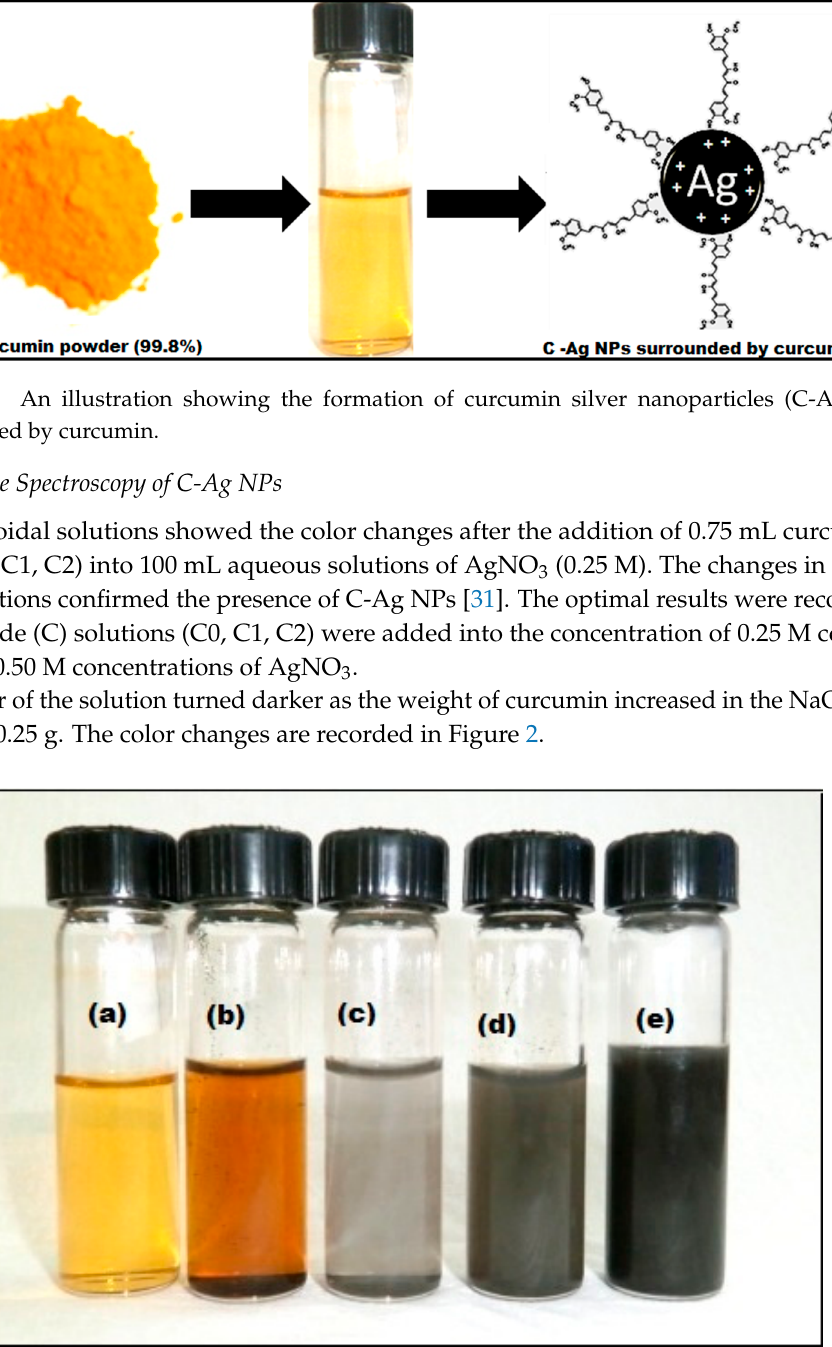
Figure 2. Changes in the color of the colloidal solution with various concentration of curcumin indicating the formation of C-Ag NPs: ( a ) curcumin solution ( b ) curcumin oxide ( c ) C0, 0.05 g curcumin ( d ) C1, 0.1 g curcumin ( e ) C2, 0.25 g curcumin.